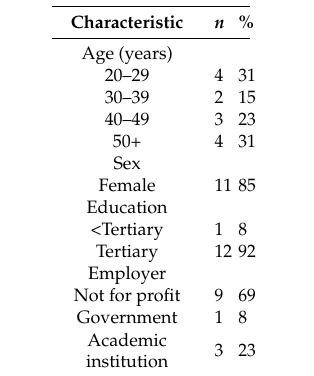
Table 1. Characteristics of stakeholders ( n =